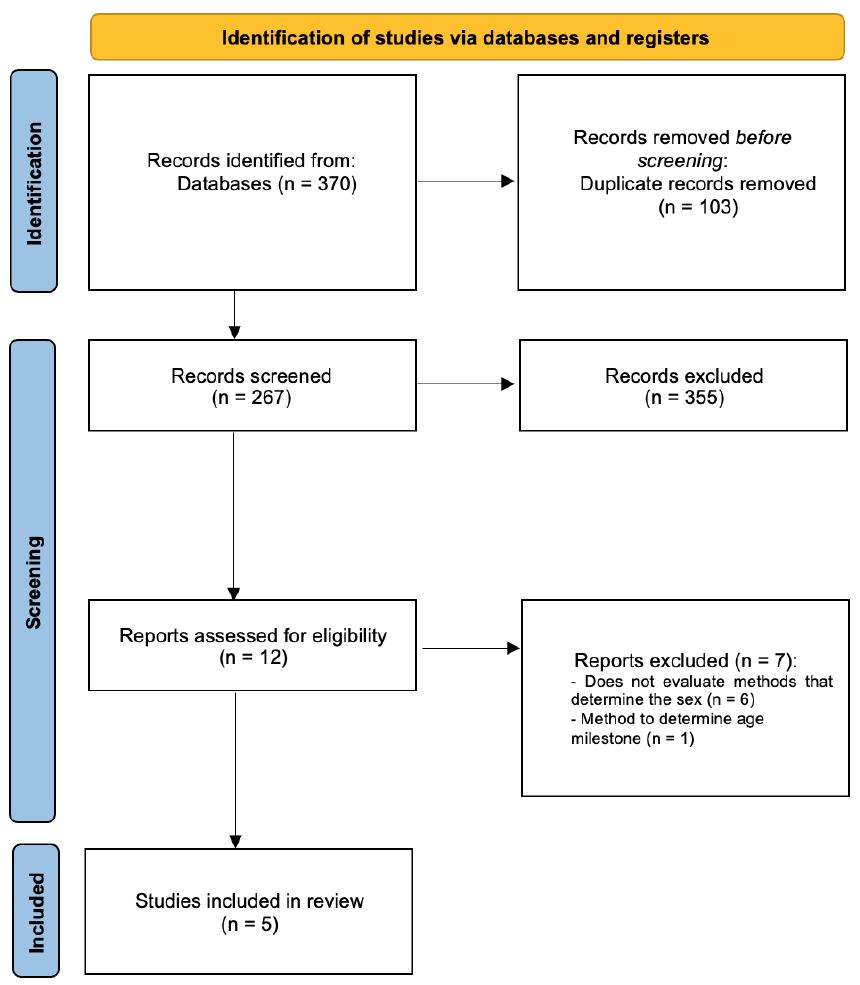
Figure 1. PRISMA flowchart of included studies.